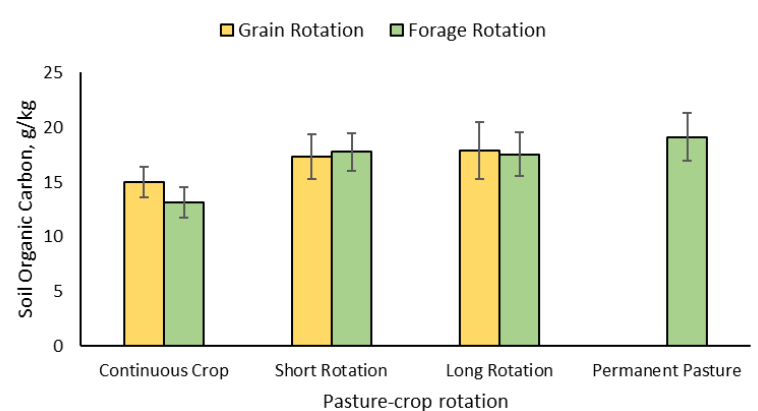
Figure 6. Pasture–crop rotation impact on soil organic carbon (mean ± s.d; 0–15 cm depth) from the ‘Palo a Pique’ long-term experiment (1995–2015). Adapted from Terra and Macedo [33].